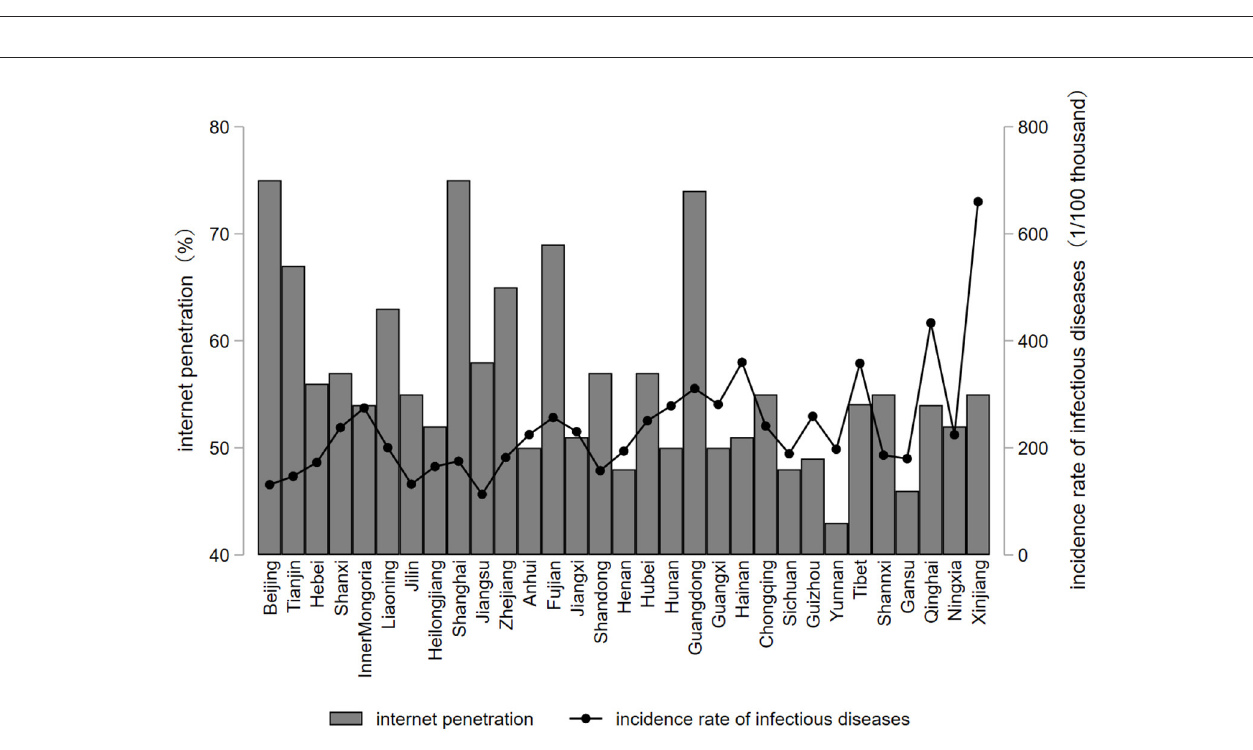
FIGURE2 Internet penetration rate and infectious diseases by province, 2018.